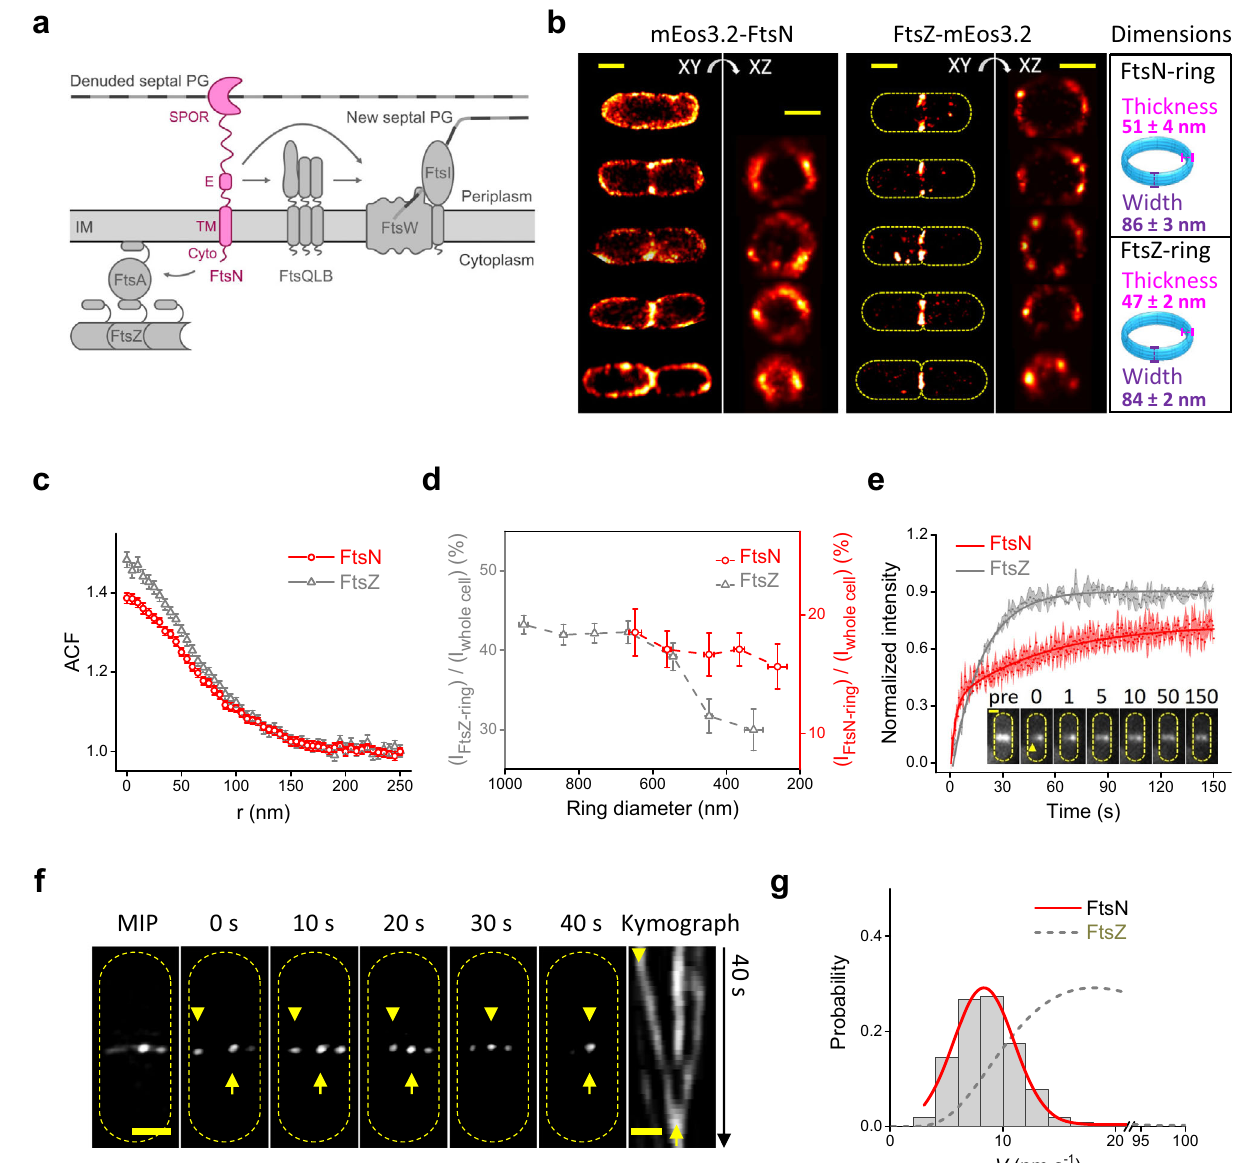
Fig. 1 | FtsN-ring has a different organization and dynamics compared to FtsZ- ring. a Schematic drawing of FtsN ’ s domain organization and interactions with other divisome proteins. b Three-dimensional (3D) superresolution images show thatFtsN-rings(left,mEos3.2-FtsNfusion,StrainEC4443inSupplementaryTable1) are patchy but more homogenous than FtsZ-rings (middle, data from a previous work 30 ). Yellow dashes mark cell outlines. Scale bars, 500nm. Toroid ring models (cyan) with the average ring dimensions are shown on the right. c Mean spatial autocorrelation function (ACF) curve of FtsN-rings (red) averaged from all indivi- dualcells ’ ACFsalongthecircumferenceofthering( r )haslowercorrelationvalues at short distances and longer characteristic decay length than FtsZ-ring ’ s ACF (gray),indicatingamorehomogenousdistributionofFtsN. d Pseudotimecourseof FtsN ’ s midcell localization percentages ( I ring / I wholecell ) during cell division suggests that FtsN disassembles later than FtsZ (gray). In ( b – d ), n =72 rings for FtsN and n =103 rings for FtsZ (data from a previous work 30 ). Data are presented as mean ± In comparison, at the same time scale the FtsZ-ring recovered with a halftimeof~16sandto~90%oftheintensitypriortobleaching(Fig.1e, gray, datafrom aprevious work 36 ). Thefast recovery phaseof FtsN was also previously observed by Söderström et al. 41 , and is most likely due to the random diffusion of FtsN molecules in and out of the septum as expected for a typical inner membrane protein